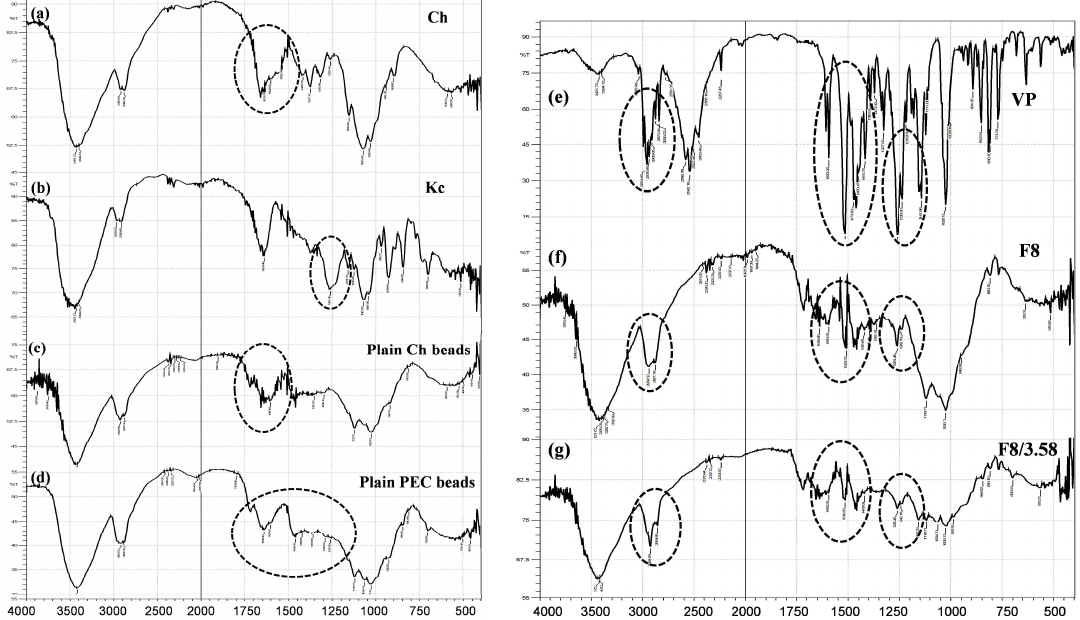
Figure 10. Spectra of ( a ) Ch, ( b ) Kc, ( c ) plain Ch-beads, ( d ) plain PEC beads, ( e ) VP, ( f ) VP-loaded Ch-based beads (F8) and ( g ) VP-loaded Ch / Kc-PEC-based beads (F8 / 3.58). Dotted circles indicate locations with characteristic peaks.